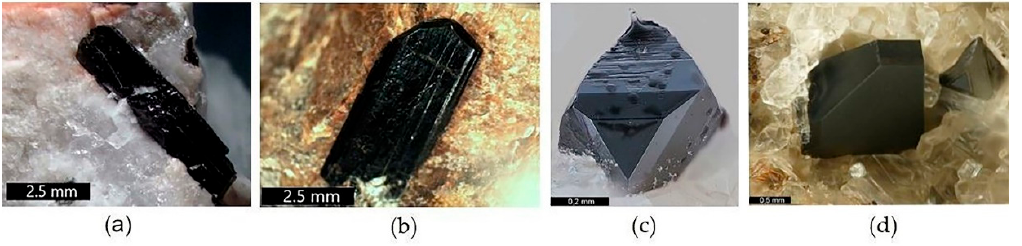
Figure 2. Natural zirconolites: ( a , b ) 3O (Vestfold og Telemark, Norway); and ( c , d ) 3T (Eifel Volcanic Fields, Germany; Fogo Volcano, Portugal).